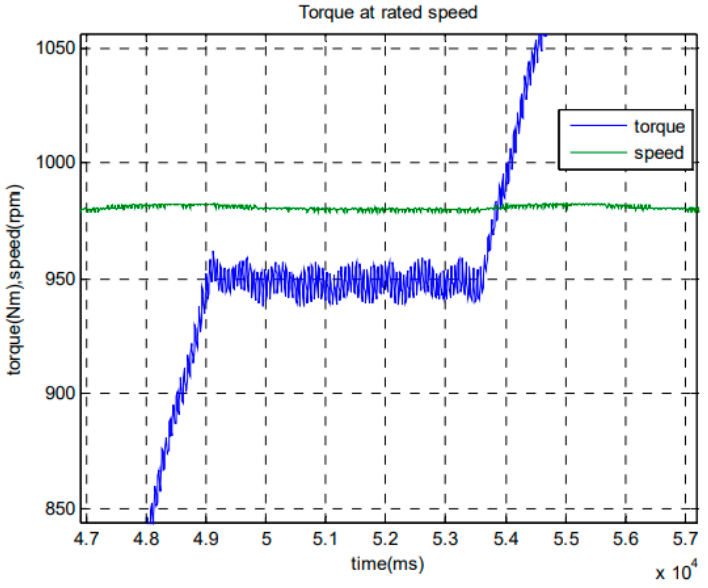
Figure 28. Torque pulsations by MPC method.